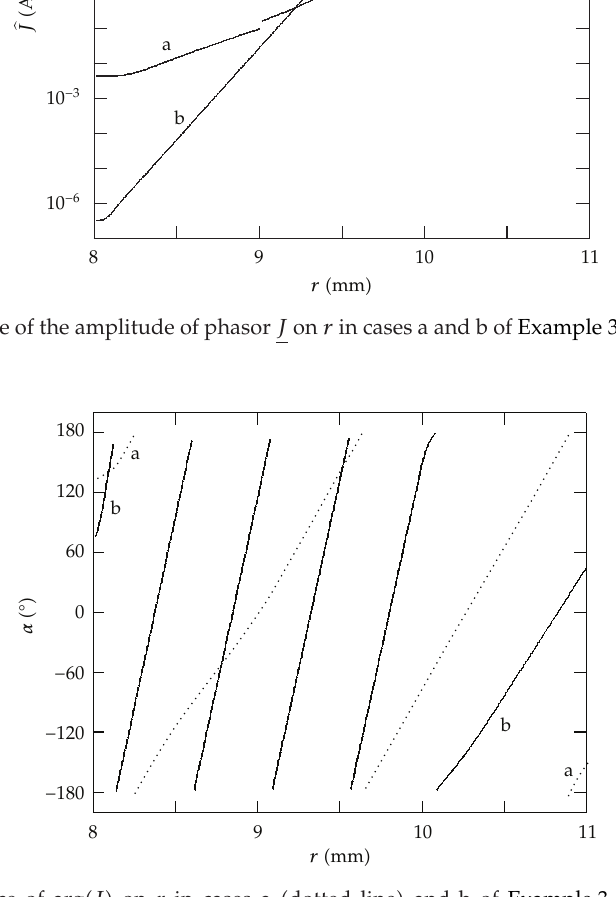
Figure 7: Dependence of arg (cid:5) J (cid:6) on r in cases a (cid:5) dotted line (cid:6) and b of Example 3.4; number of partial conductors N (cid:7)